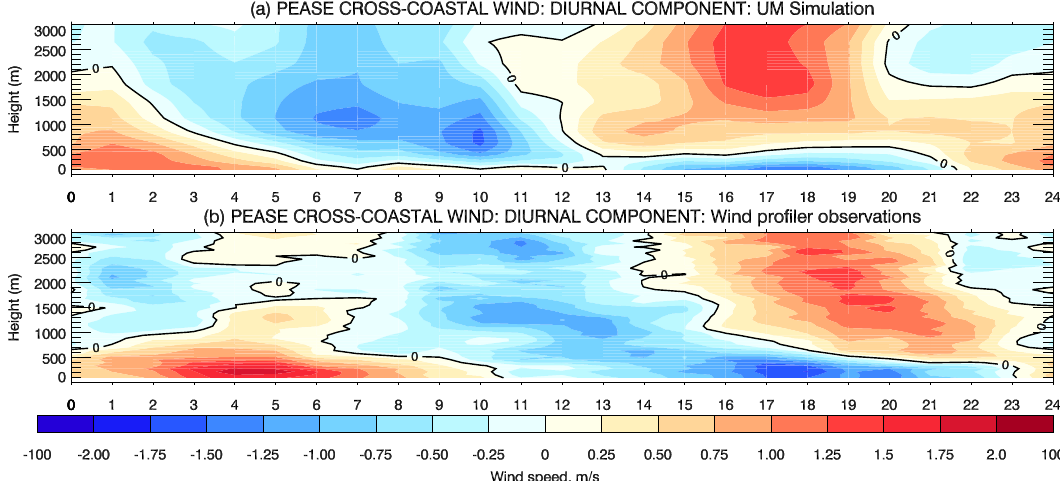
Figure 3. 27day average diurnal component of cross-coastal direction wind speed at Pease (a) as simulated by the MetUM and (b) as observed by 915MHz wind profiler. The x axis is labelled by the hour in local summer time (UTC-4). Positive wind speeds represent offshore flow and negative wind speeds represent onshore